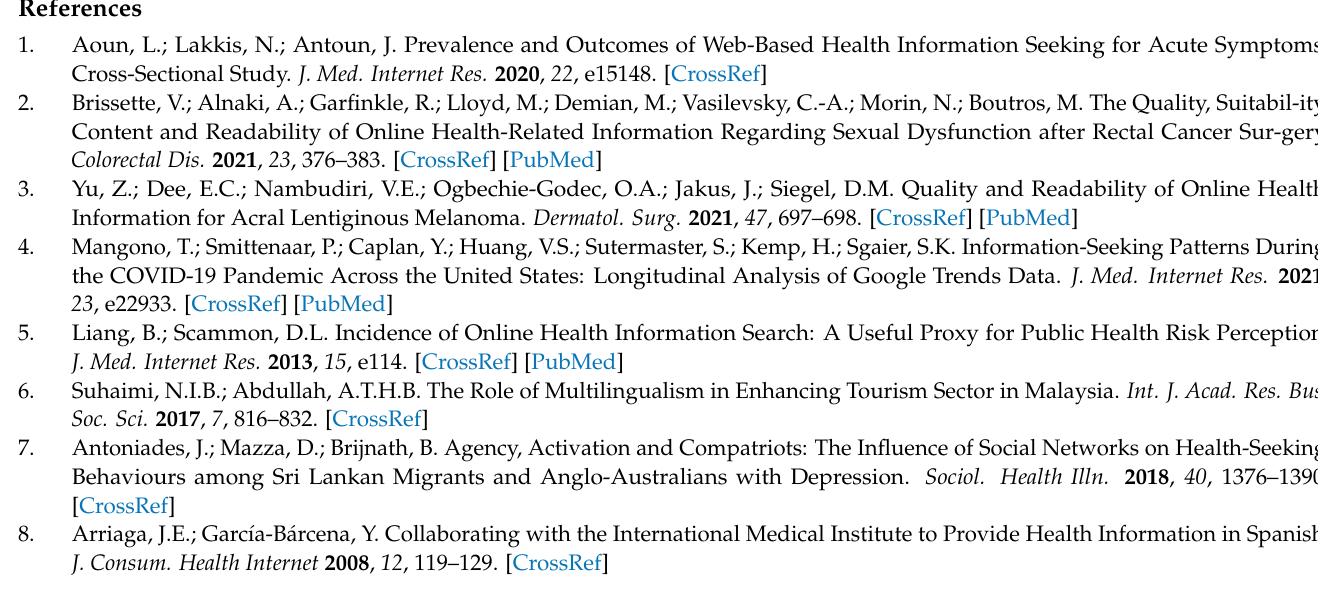
Table S2: Demographic, geographic and medical facilities statistics for statistical analysis, Supple- mentary Table S3: SQUIRE reporting